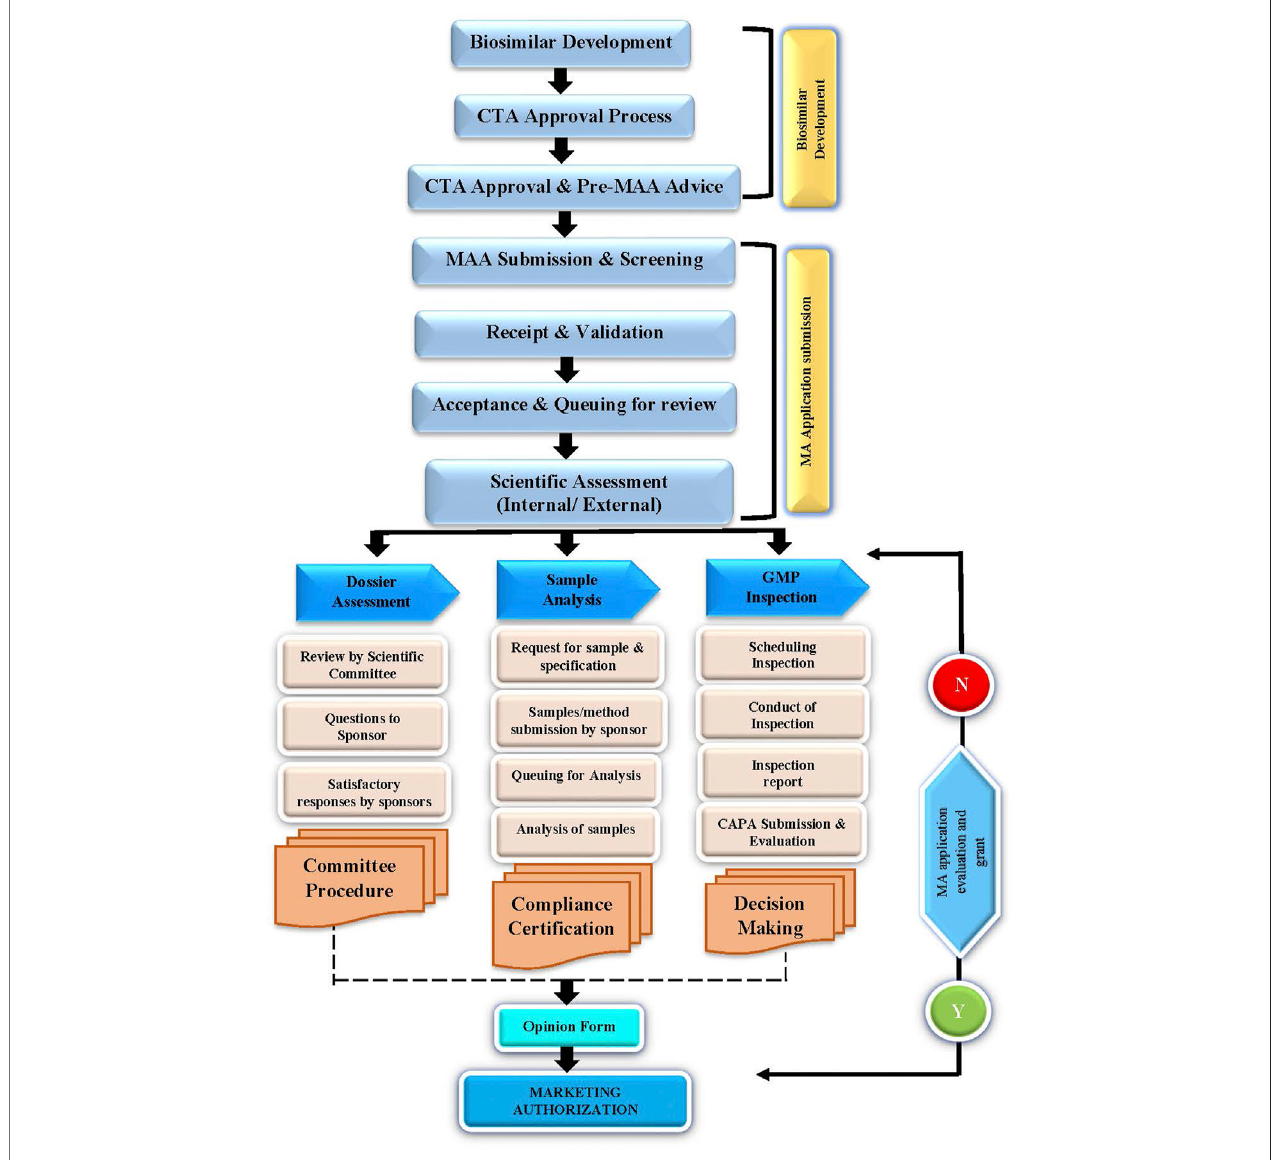
FIGURE 1 | Dossier review and approval